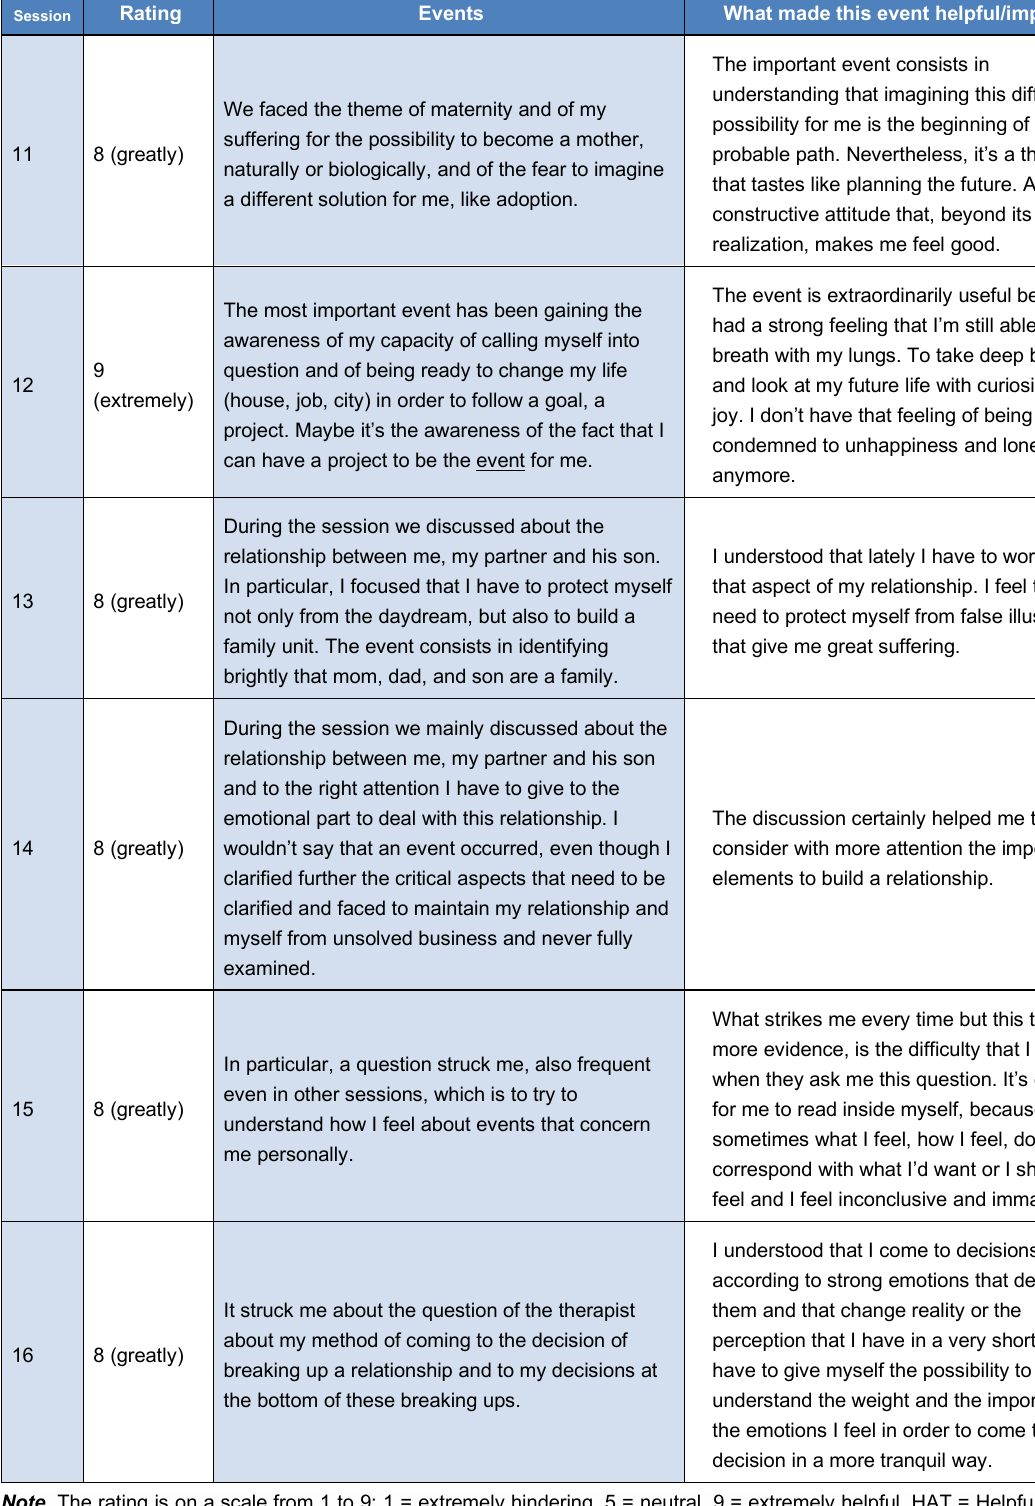
Table 3: Beatrice’s helpful aspe ct of therapy (HAT